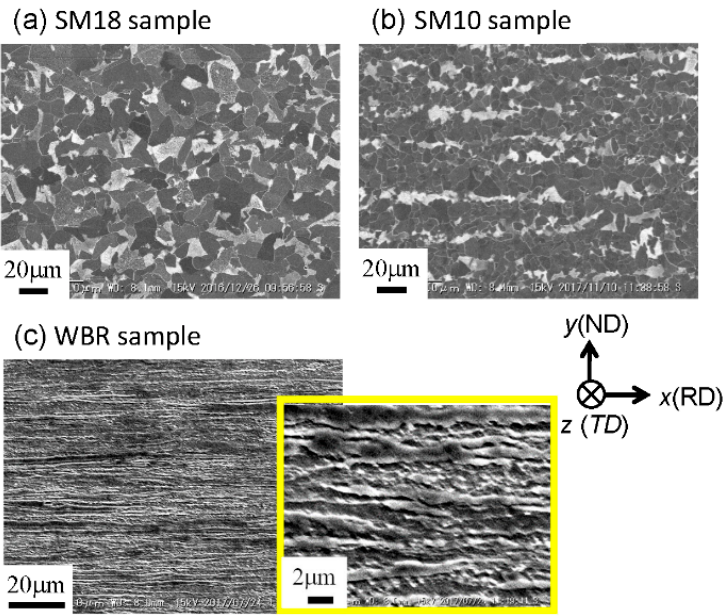
Figure 1. SEM images of the microstructures at the center of the cross-sectional plane parallel to the rolling direction (RD).